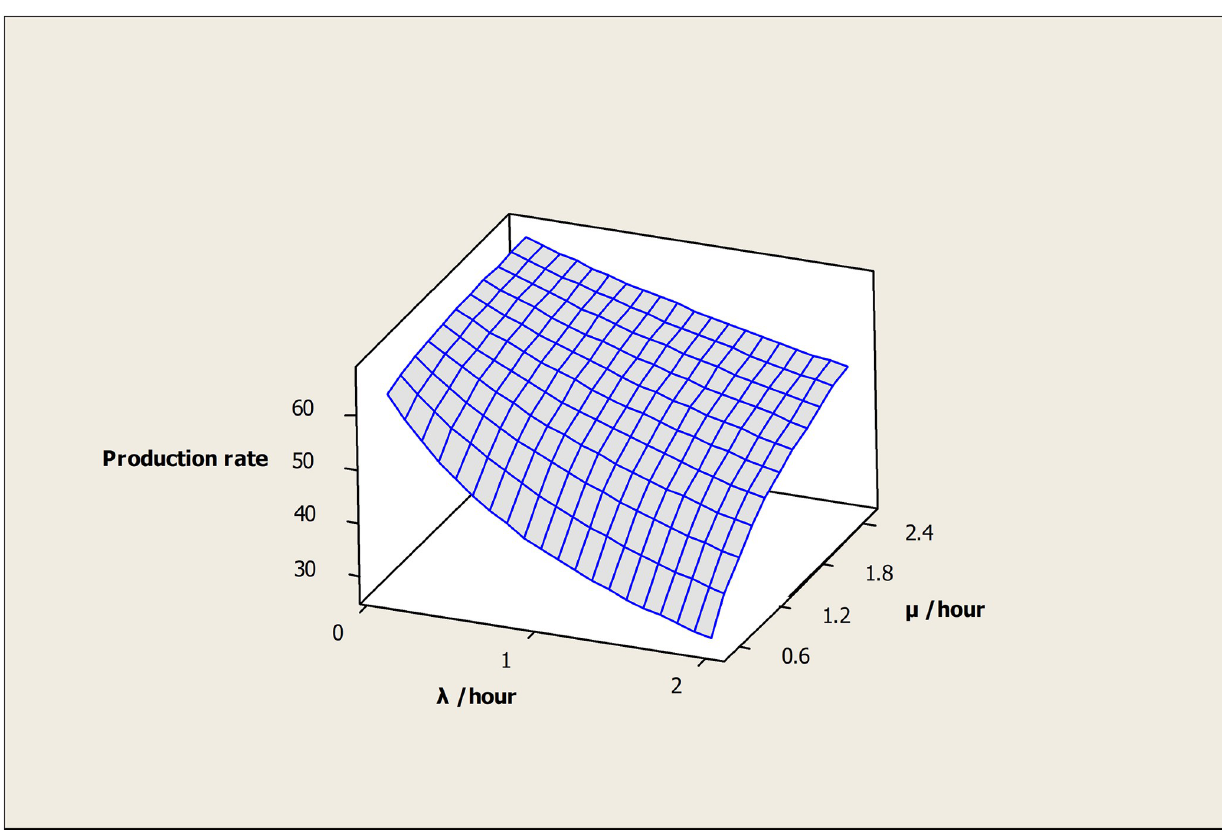
Fig 12. Surface plot of production rate versus μ /hour, λ